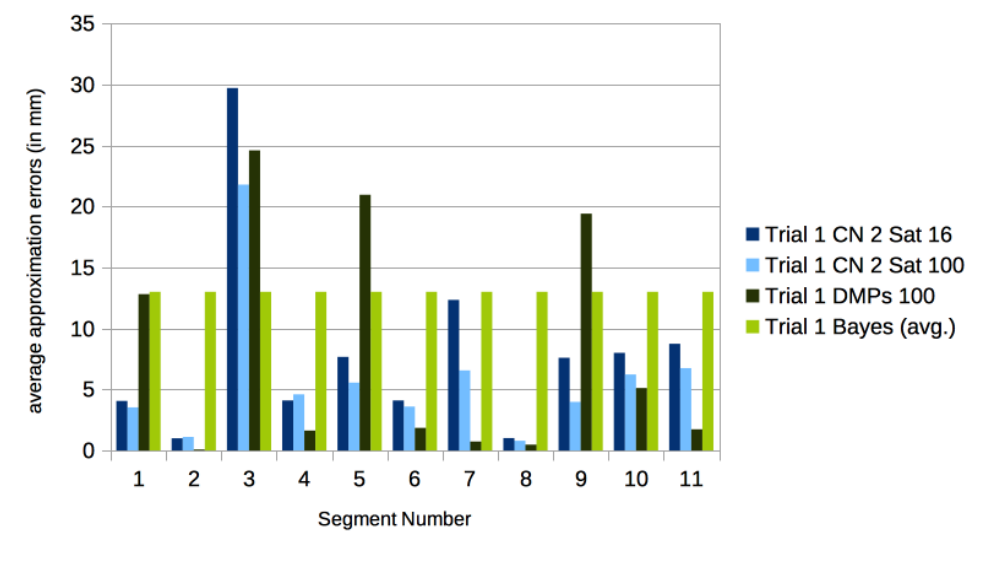
Figure 15. Approximation errors (in mm) for the algorithmically found segments of motions in CMU 86 Trial 1. We give the errors for using 16 and 100 satellites. As a comparison we give the results using rhythmic dynamic movement primitives (DMPs) with 100 basis functions computed with pydmps, and the average approximation error of the Bayesian approach reported in [28] (Table 3). Notice that segments 2, 4, 6, and 8 are short transitional motions between the neighboring segments. The average over all segments is 8.7 mm for the DMPs, 7.9 mm for two centers and 16 satellites, and 6.7 mm for two centers and 100